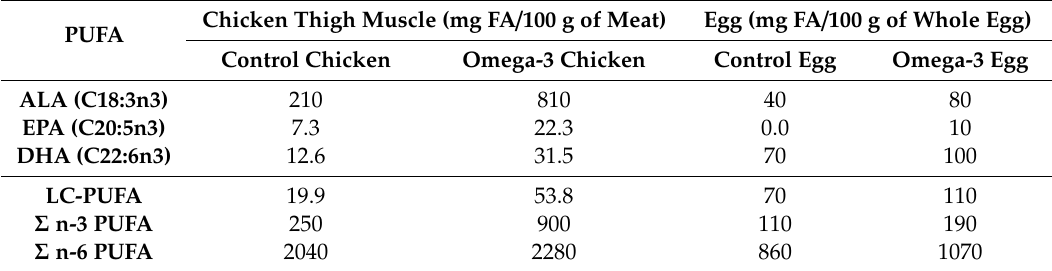
Table 1. PUFA composition of omega-3 chicken and